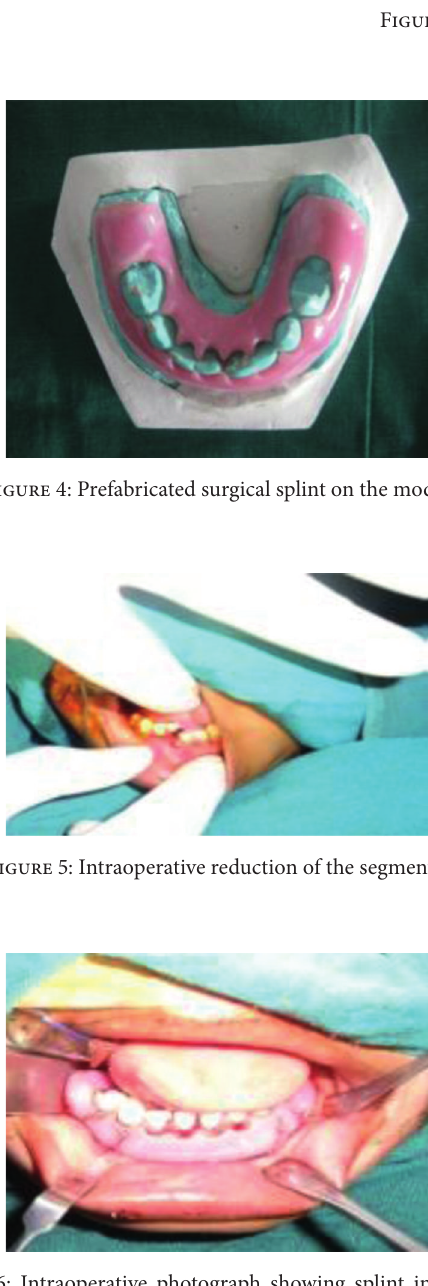
Figure 9: Preoperative IOPA of 73–83 region showing displaced 71 and